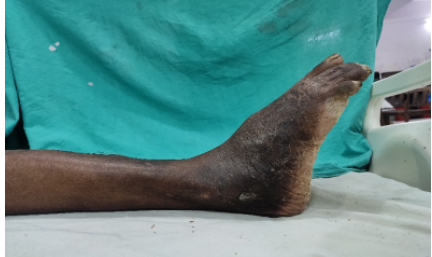
Figure 9. PLANTAR FLEXION AT ANKLE AFTER 6 MONTH